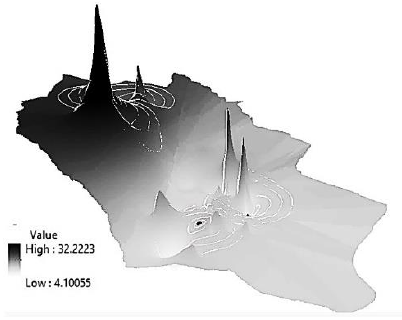
Figure 6. Three-dimensional map represents the glutathione S transferase (GST) activity.